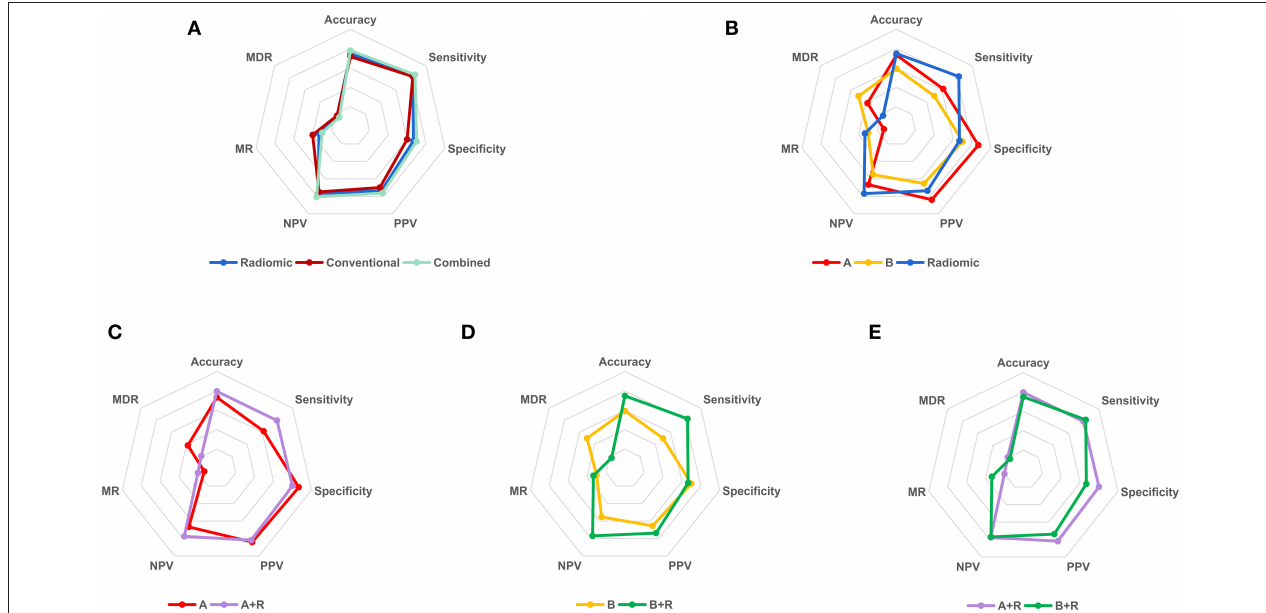
FIGURE 5 | The binary diagnosis of predictive models and two radiologists. (A), the first binary diagnosis of the senior radiologist A with 10-year experience in thoracic imaging diagnosis in test cohort; (B), the first binary diagnosis of the junior radiologist B with 2-year experience in medical imaging diagnosis in test cohort; R, the binary diagnosis of radiomic predictive model in test cohort; A + R, the second binary diagnosis of radiologist A in test cohort with the aid of radiomic predictive model; B + R, the second binary diagnosis of radiologist B in test cohort with the aid of radiomic predictive model. PPV, positive predictive value; NPV, negative predictive value; MR, misdiagnosis rate; MDR, missed diagnosis rate.